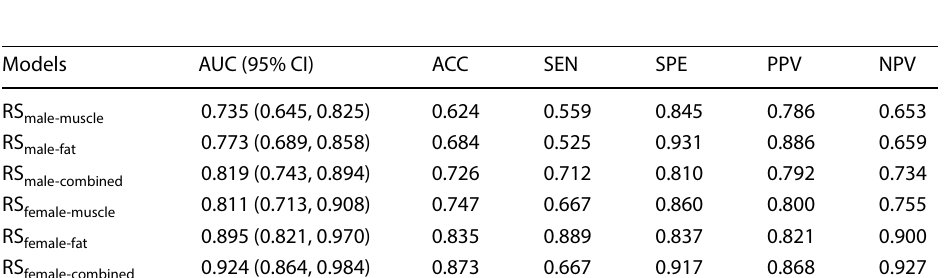
Table 2 Performance of Prediction Models for Predicting LNM of localized pancreatic ductal